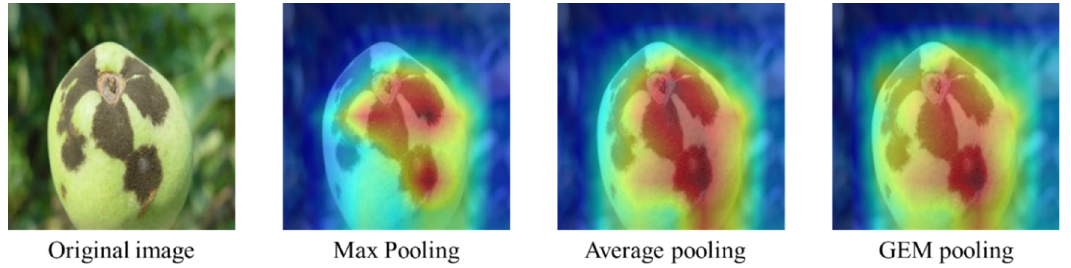
Figure 10. Activation status of different pooling methods in FEA.